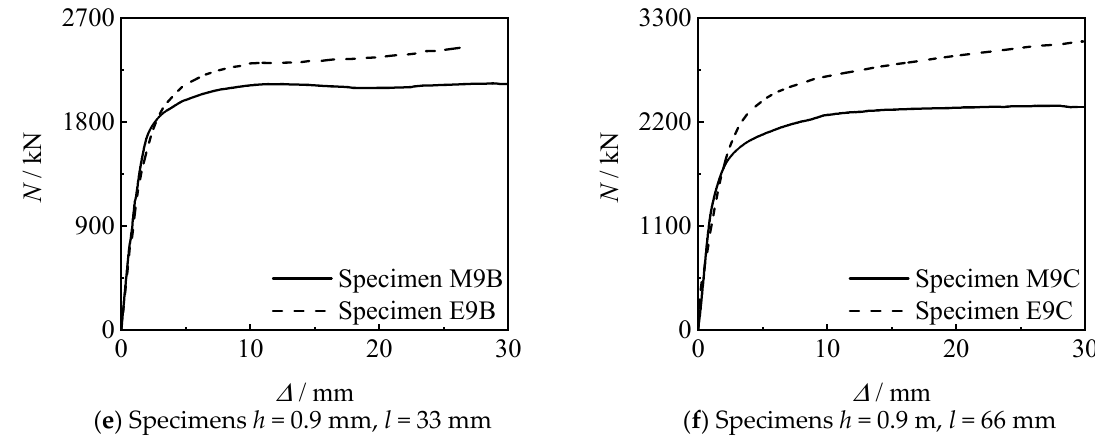
Figure 13. Effect of thread position on N- Δ curves of specimens.